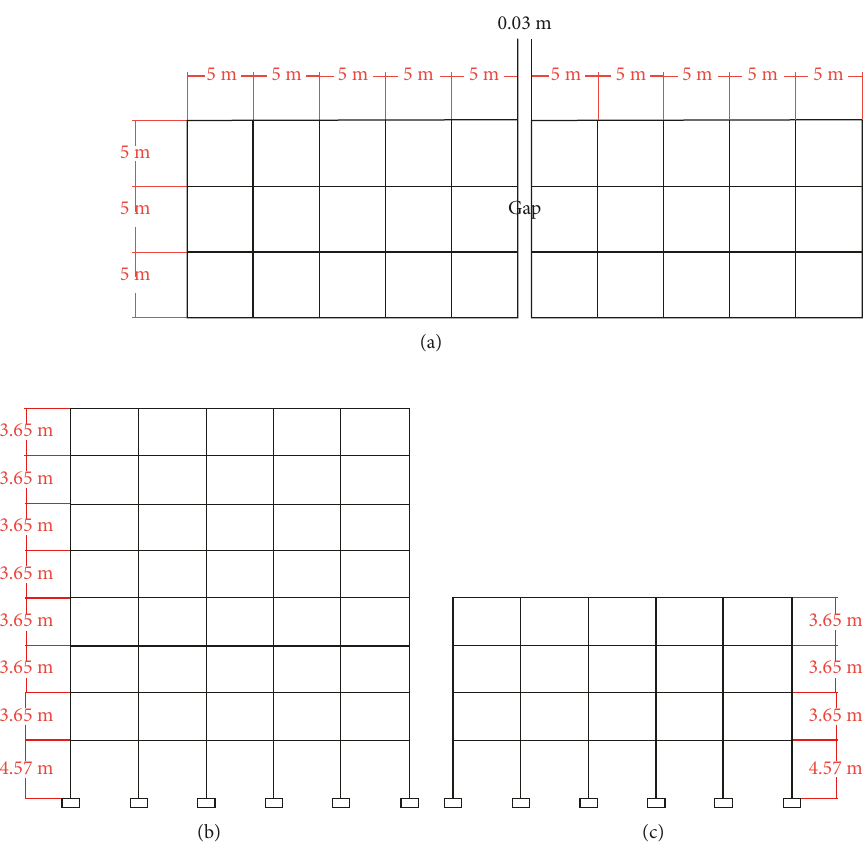
Figure 4: Plan and elevation views of buildings having segregated foundations. (a) Plan view; (b) 8-storey-level elevation view; (c) 4-storey- level elevation